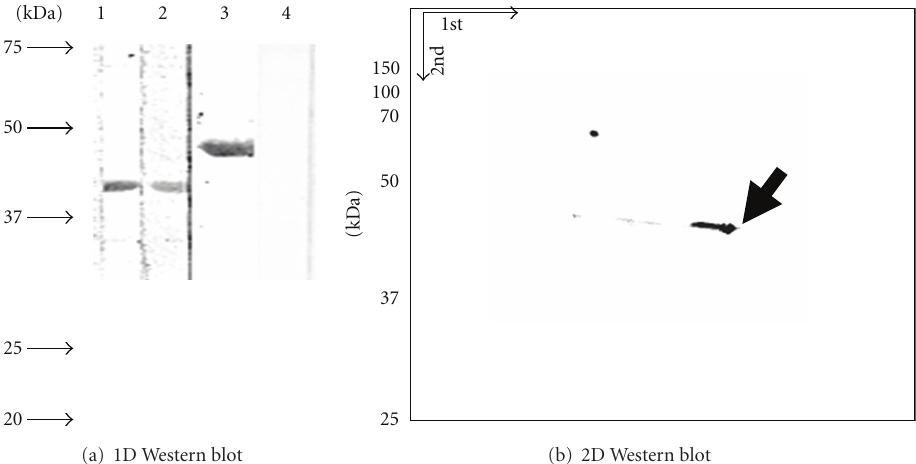
Figure 4: Binding of EF-Tu to fibronectin examined by Western-blot-based binding assays. (a) Proteins were resolved by SDS-PAGE and blotted onto PVDF membranes. Proteins from OM (lane 1) and OMVs (2) and the purified rEF-Tu (3) were probed with FN and anti-FN. rEF-Tu (4) and proteins from OM (not shown) probed with anti-FN alone. (b) Immunoblot of 2-DE of proteins from OM probed with FN followed by anti-FN. Arrow indicates EF-Tu confirmed by protein sequencing.